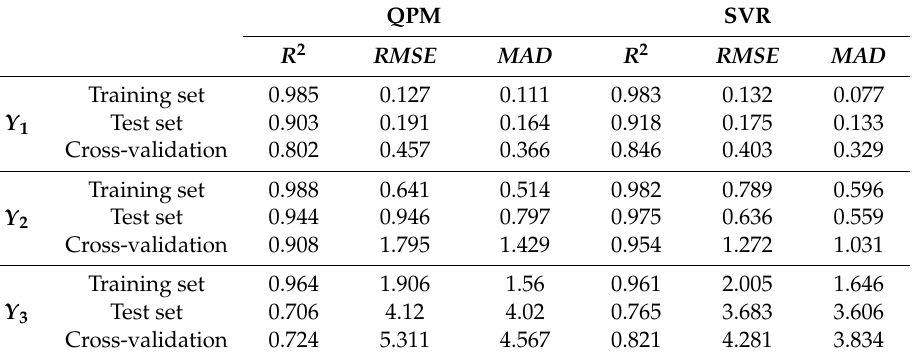
Table 2. Statistical parameters of the quadratic polynomial model (QPM) and the support vector regression (SVR) model.